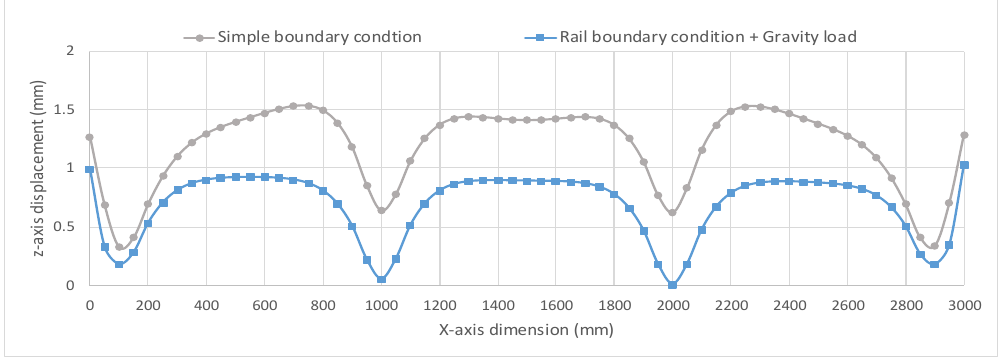
Figure 15. Z-axis displacement distribution along line L of Sequence B-10 under two different boundary conditions.